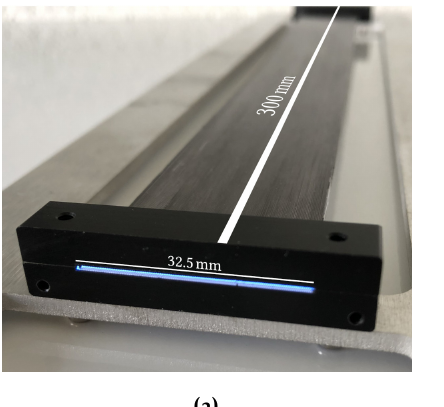
Figure 10.15: Time resolution of a 4 layer SCSF-78MJ SciFi ribbon extracted from clusters with at least 2 act- ive columns. No channel by channel time oset correction has been applied. Figure 10.16: Overall structure of the scintillating fibre Figure 10.2: Full size SciFi ribbon prototype with prelim- detector. inary holding structure. The SciFi ribbon is formed by Figure 10. ( a ) Prototype of a scintillating fiber ribbon, formed by staggering three layers of round staggering three layers of round scintillating fibres. scintillating fibers. ( b ) Structure of the SciFi detector, with the scintillating fiber ribbons shown in light blue